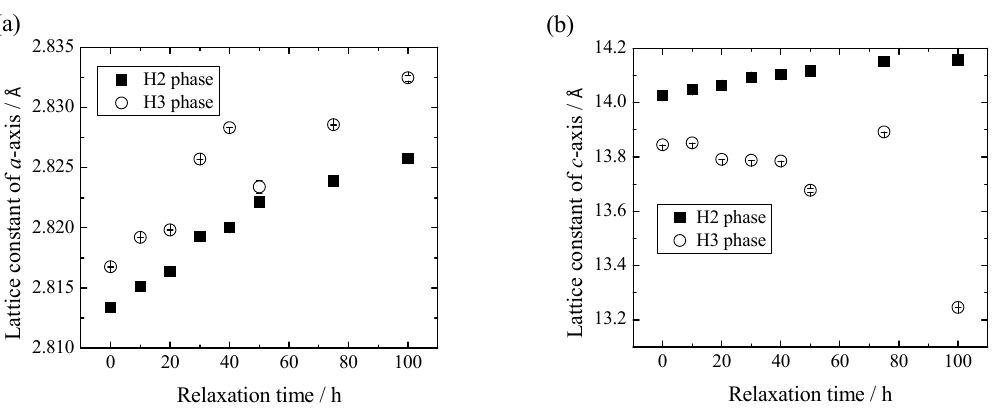
Figure 5. Change in lattice parameters of the ( a ) a -axis and ( b ) c -axis of Li 0.12 Ni 0.874 Co 0.090 Al 0.036 O 2 with relaxation time. Closed and open symbols correspond to the H2 and H3 phase, respectively.